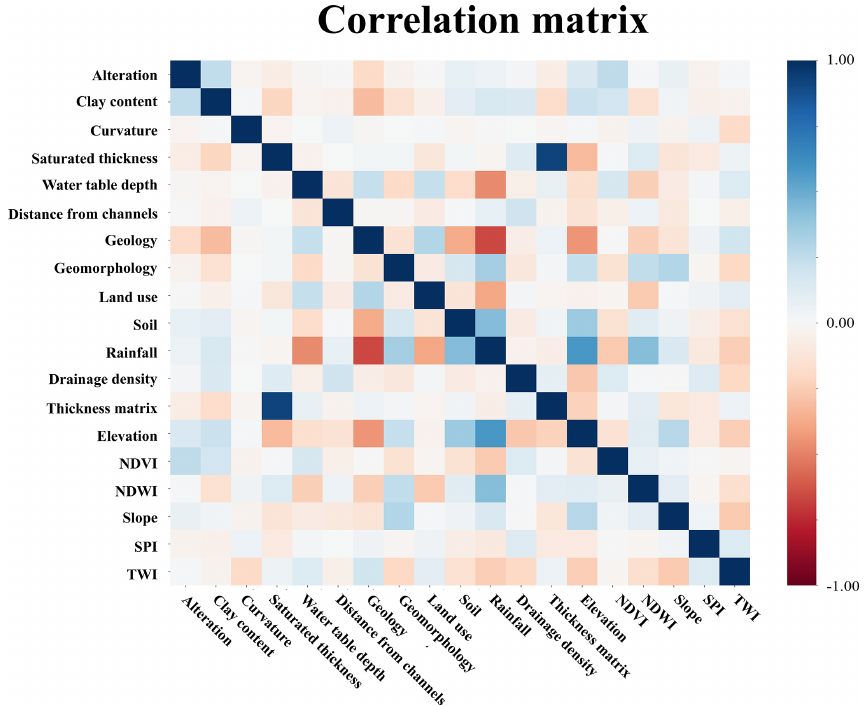
Figure 8. Pairwise collinearity analysis for all explanatory variables.